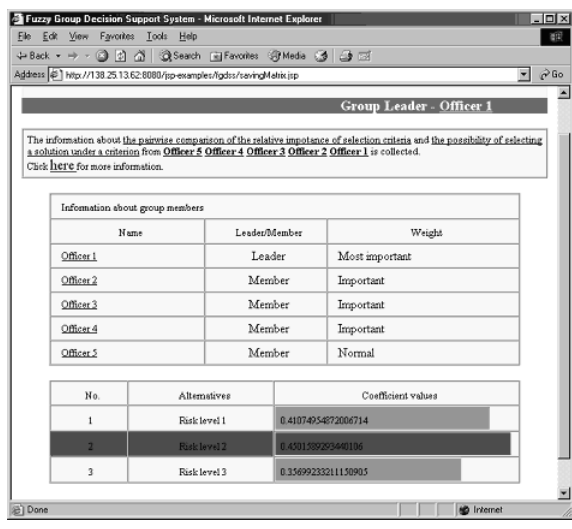
Fig. 6. The final result for the consensus SA in the team Further study includes the development of ap- proaches of team situation assessment to directly